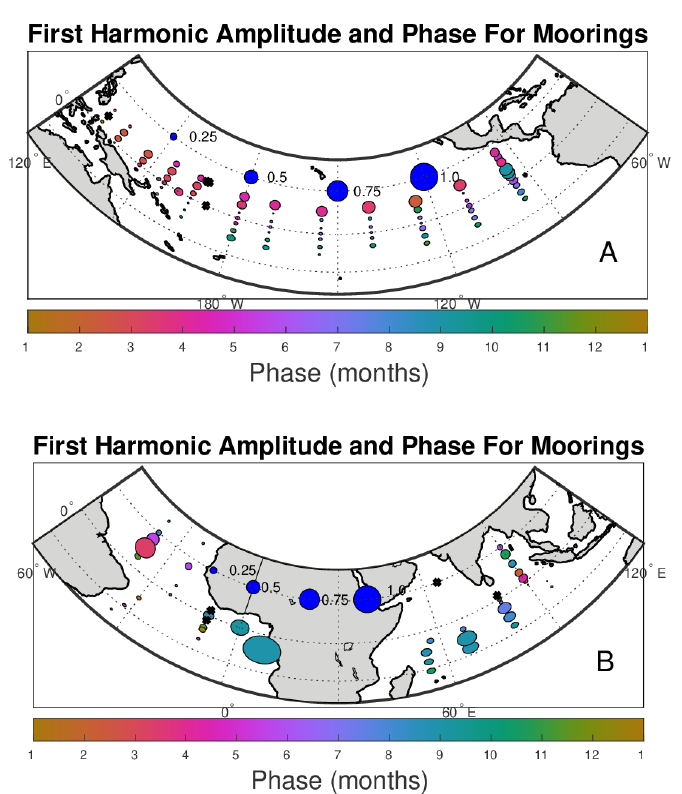
Figure 3. Amplitude and phase of the first harmonic from the moorings. Each symbol is for one mooring at its given location. The amplitude is indicated by the area of the symbol, with scale in dark blue near the top middle of each figure. The color of each symbol indicates the phase, as the month of maximum SSS, with color scale in months (January–January) at the bottom. Symbols with a black “X” were either found not to have a significant fit to the annual harmonic, or contained less than one year of observations. The maps use an equal area conic projection. This means that though the symbols change in shape from north to south, the relative areas are depicted correctly in relation to the dark blue scale. (a) Pacific basin. (b) Atlantic and Indian basins. For completeness, we include maps of amplitude and phase for all products for both annual (Table S1) and semiannual (Table S4) harmonics. Next, we show maps of fraction of variance, R 2 , explained by the harmonic fit (Figure 4). In the Pacific basin, the numbers tend to be larger, over 0.5, in the ITCZ, in the western Pacific and south of the equator in the eastern Pacific, whereas they are small along the equator. In the Atlantic most of the values are large, especially near the coast of Africa. In the Indian basin, the values get very large, approaching 1 in the western South Indian basin. All of these results indicate that in many parts of the tropical ocean, the seasonal time scale represents a large fraction of the total signal [20,21].